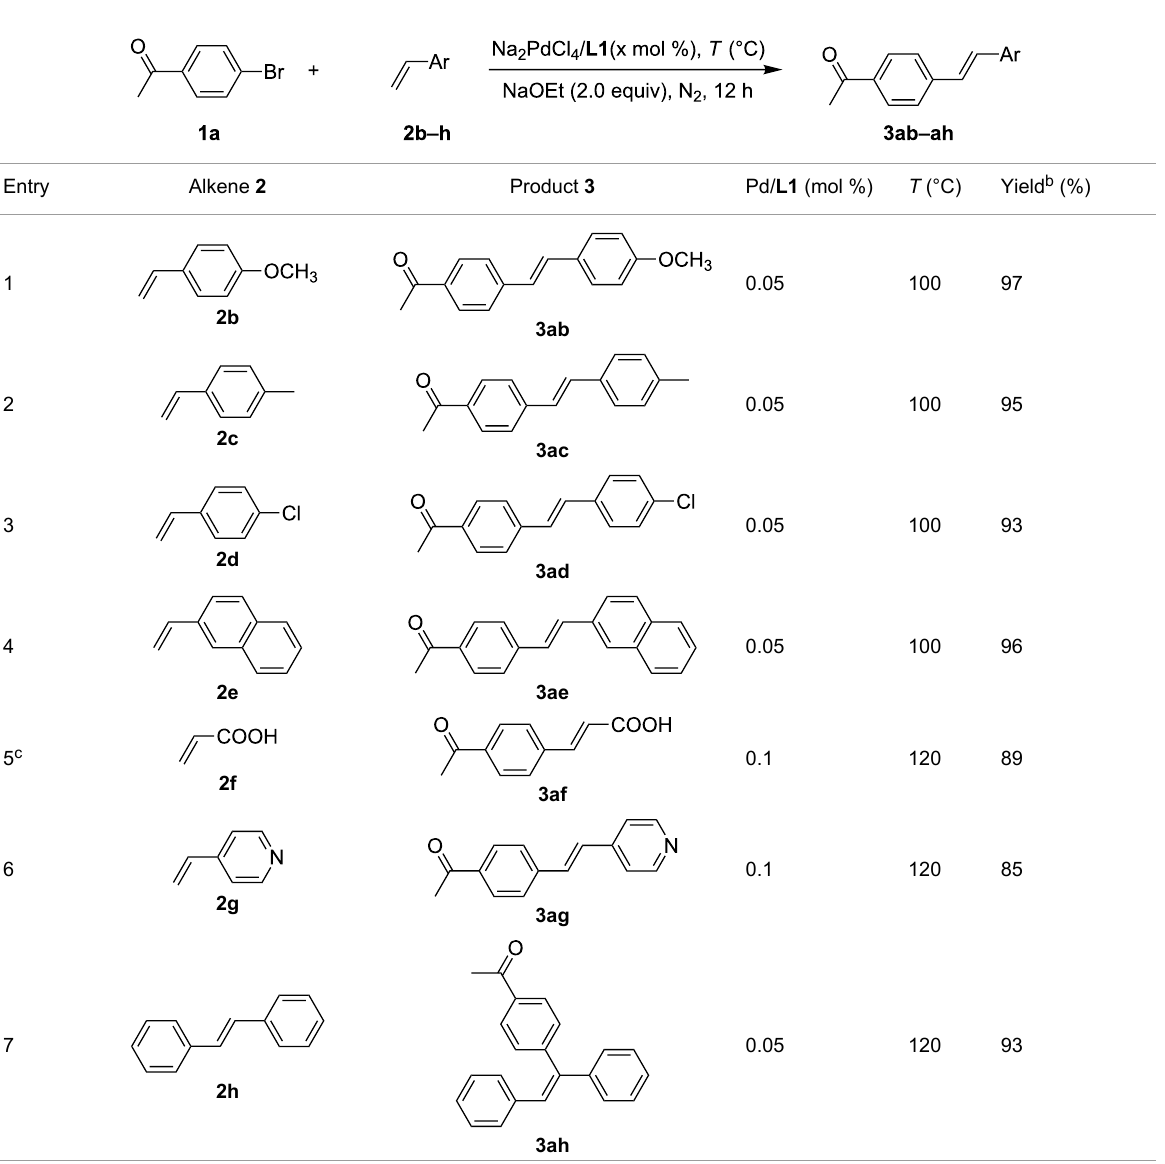
Table 3: Mizoroki–Heck reactions between 4-bromoacetophenone and various alkenes.